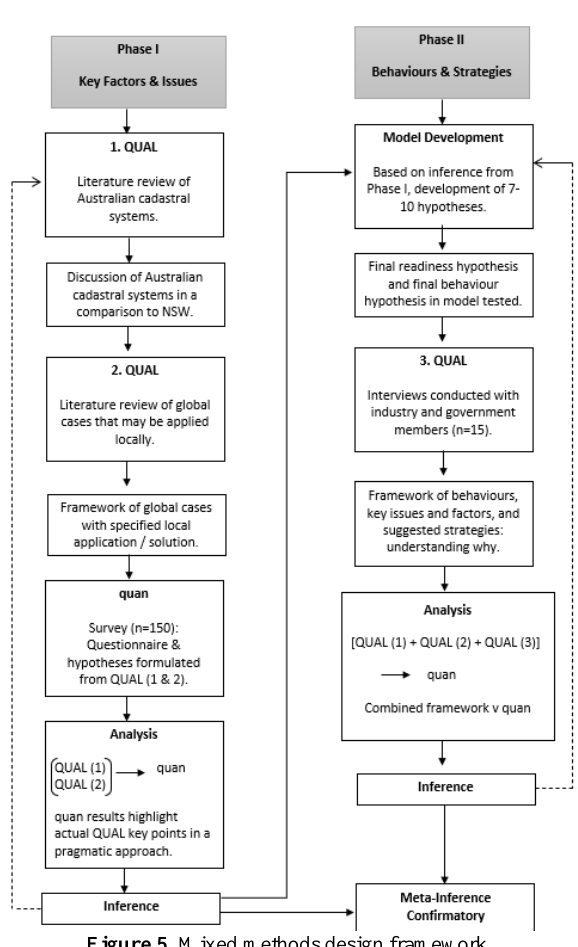
Figure 5 . Mixed methods design framework